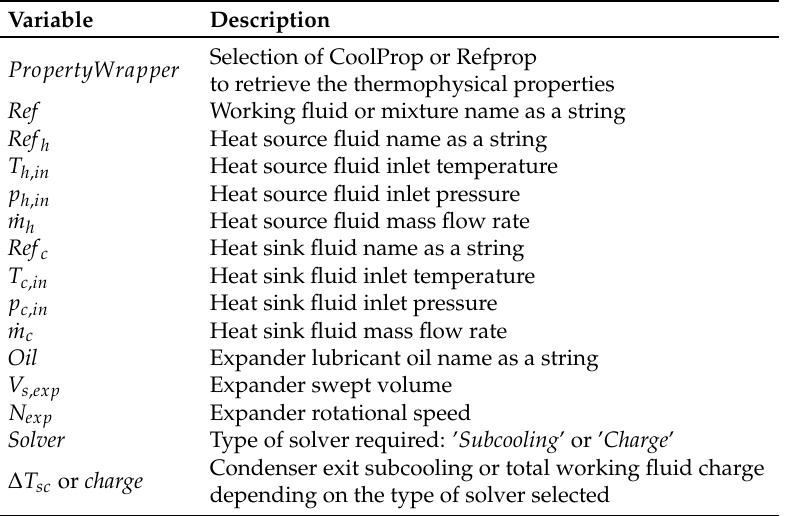
Table 2. Required inputs to the overall ORC